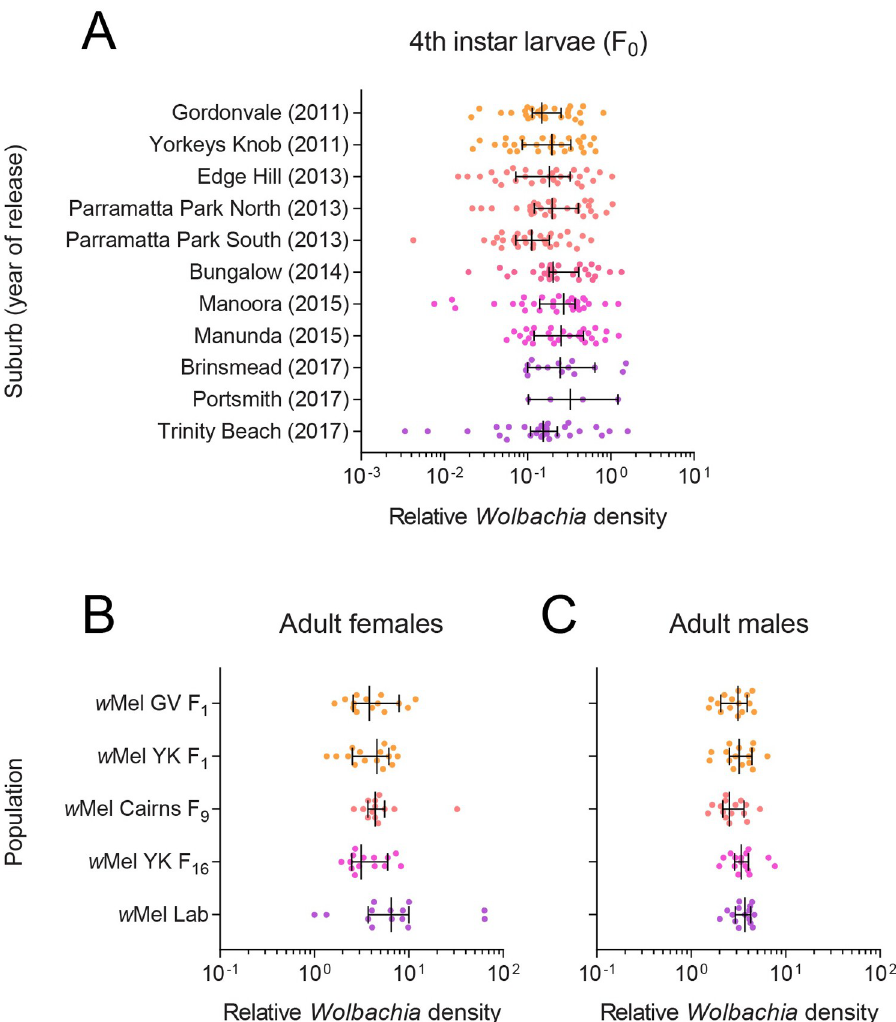
Fig 1. w Mel density remains stable across suburbs and laboratory generations. (A) Wolbachia density in 4 th instar larvae hatched from ovitraps collected across Cairns suburbs in February-March 2018. The year where releases were undertaken in each suburb is shown in parentheses. (B-C) Wolbachia density in adult (B) females and (C) males in populations that had been reared in the laboratory for different numbers of generations. Dots represent data from three technical replicates of an individual mosquito. Vertical lines and error bars represent medians and 95% confidence intervals.